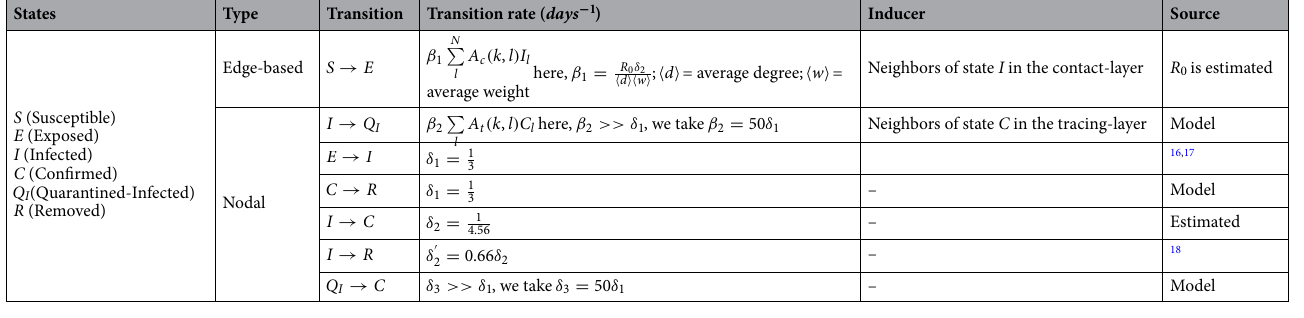
Table 6. Description of the SEICQ2 epidemic